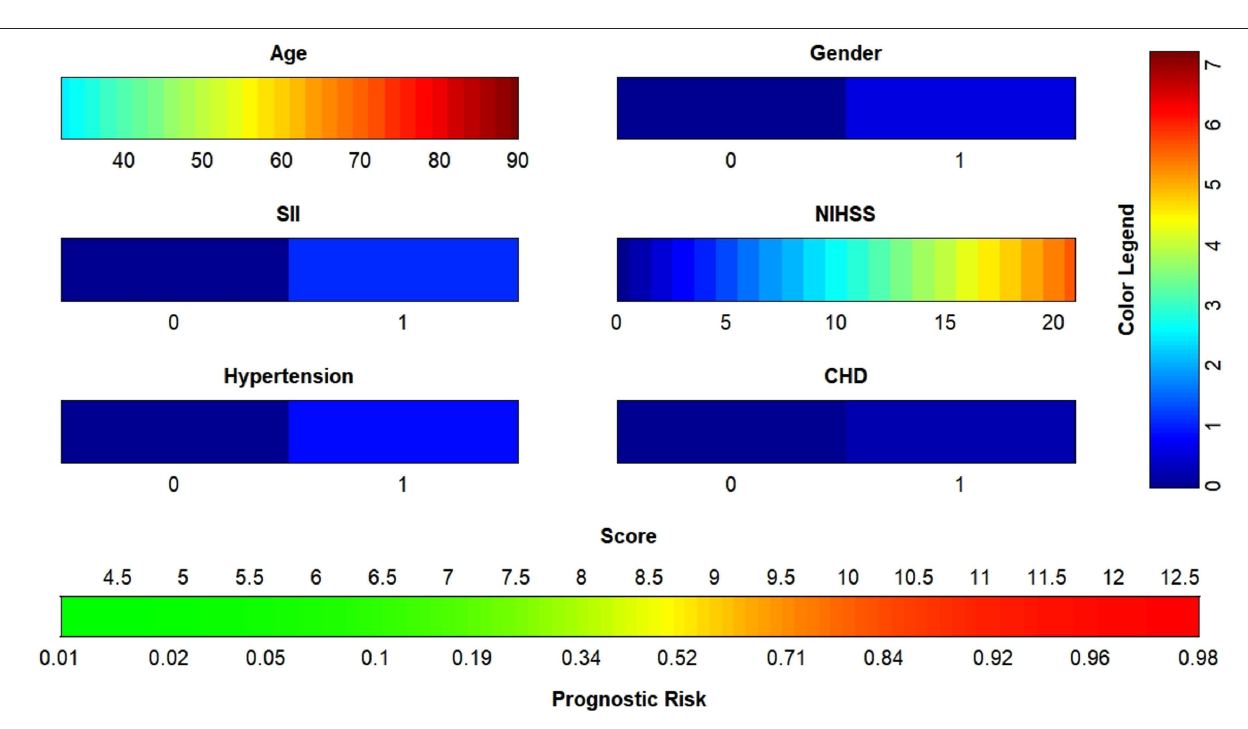
FIGURE 3 | Forest plot for clinical factors. SII, systemic immune inflammatory index; NIHSS: National Institutes of Health Stroke Scale.